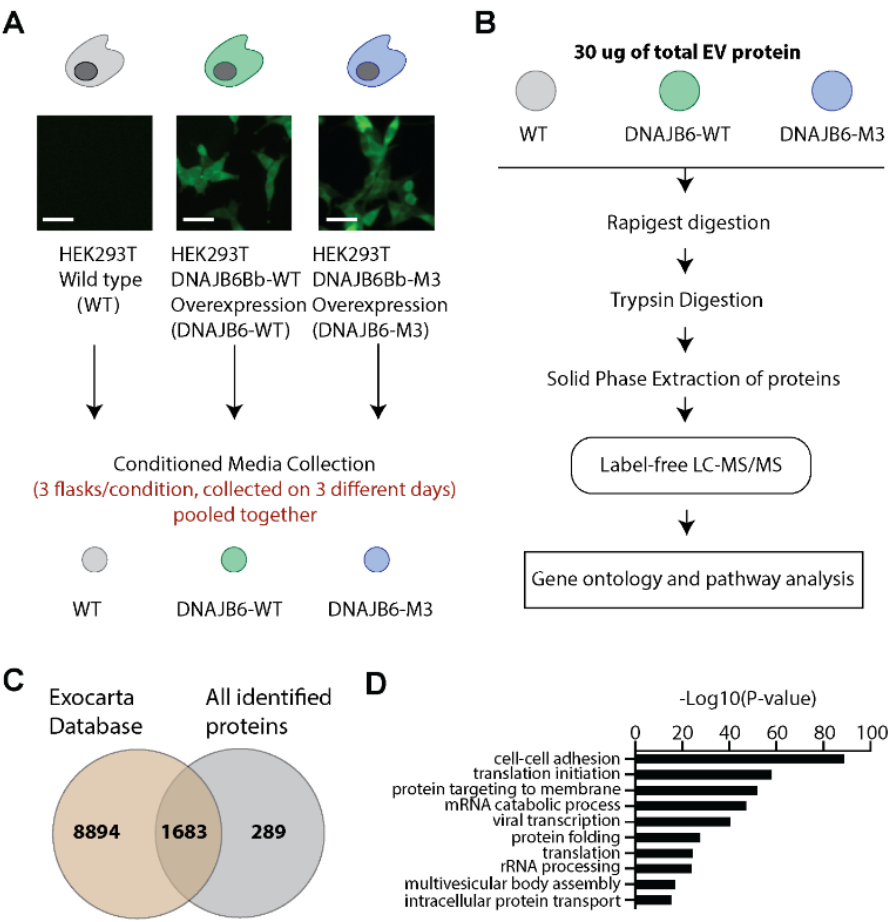
Figure 3. Global profiling of EV proteins identified using mass spectrometry. ( A ) Experimental setup for obtaining the WT, DNAJB6-WT, and DNAJB6-M3 EVs. ( B ) Workflow for mass-spectrometric analysis of EVs obtained in ( A ). ( C ) Comparative analysis of proteins identified in the isolated EVs to the published EV proteome in ExoCarta using Venn diagrams. ( D ) Top 10 significantly enriched GO biological processes in EVs under study. Table 1. Up ‐ tissue analysis for proteins enriched in WT, DNAJB6 ‐ WT, and DNAJB6 ‐ M3 EVs: top 10 tissues are listed.